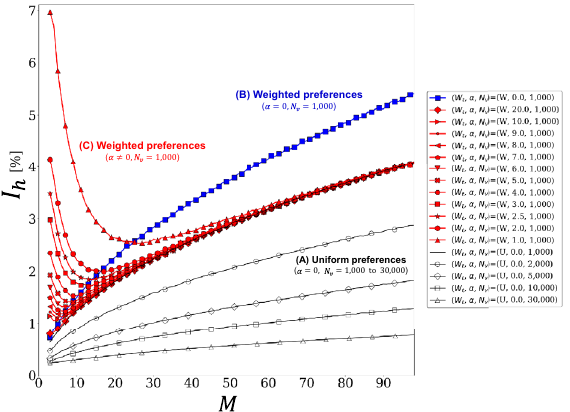
Figure 4. Dependence of imbalance ratio I h on the parameter M in different values of N v and α in